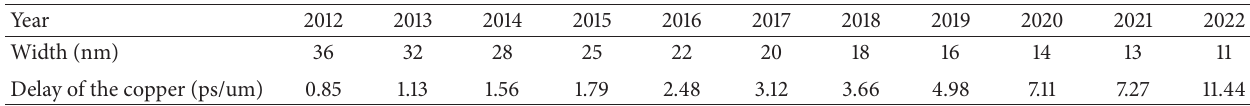
Figure 2: Different CNT interconnect geometries: (a) segregated SWCNT bundle, (b) segregated MWCNT bundle, (c) proportionately mixed CNT bundle, and (d) randomly mixed CNT bundle. Table 1: Sizing ratio used for simulation